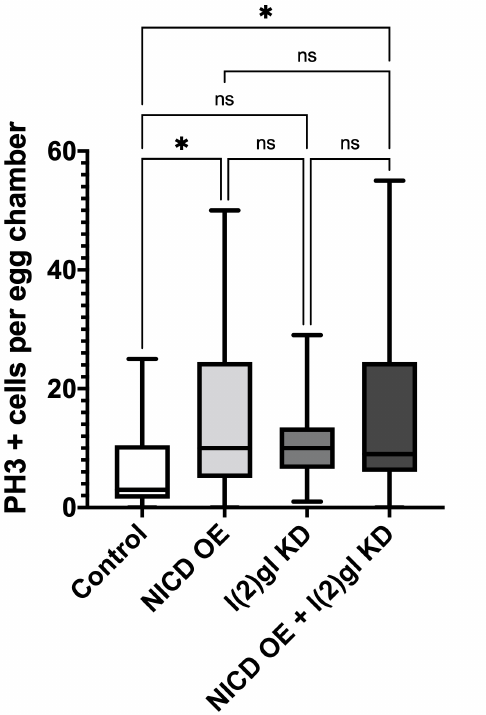
Figure A2. Comparison of proliferation between NICD and non-NICD-overexpressing gentoypes. Box and whisker plot comparing number of PH3 + cells were counted per egg chamber. Comparisons from the post hoc Tukey HSD are shown. (ns) not significant, (*) p < 0.05. N = 20 egg chambers from at least 5 individuals per condition. Genotypes with NICD OE have more proliferation than those